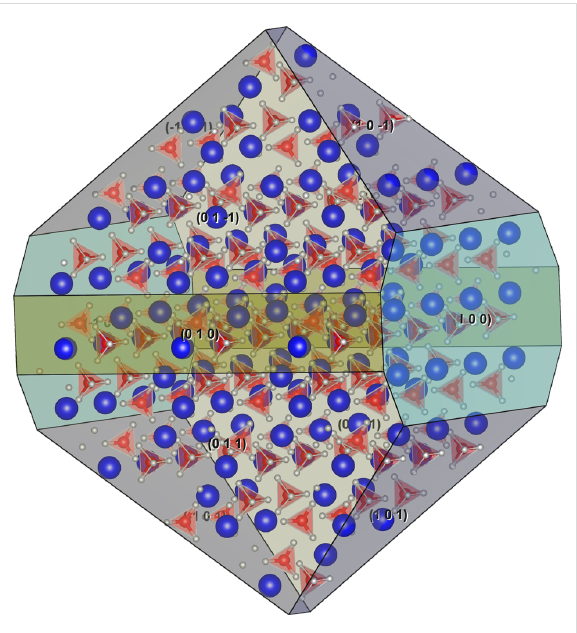
Contrary to the pure elements or metal oxides, for lithium boro- hydride the Wulff construction of the nanocrystal does not provide features that can confirm or match experimental evi- dence. The reason is the low surface energy of compound, fast rotational motion of anions, and large enthalpy of formation of small clusters. Due to the weak interaction with the host matrix the shape of LiBH 4 cluster is not perturbed by the interfacial interaction. However, NMR experiments indicate a larger shielding of the boron nucleus ( 11 B) in nanoconfined state, this can be explained only if the coordination of BH 4 − anions is lower than three (the coordination number is four in the bulk) [65]. Such low coordination is possible only for two dimen- sional structures; the surface anions in the Wulff shape crystal have coordination three. However, the intensity of NMR lines suggest that the number of low coordinated atoms is larger than the number found in the Wulff